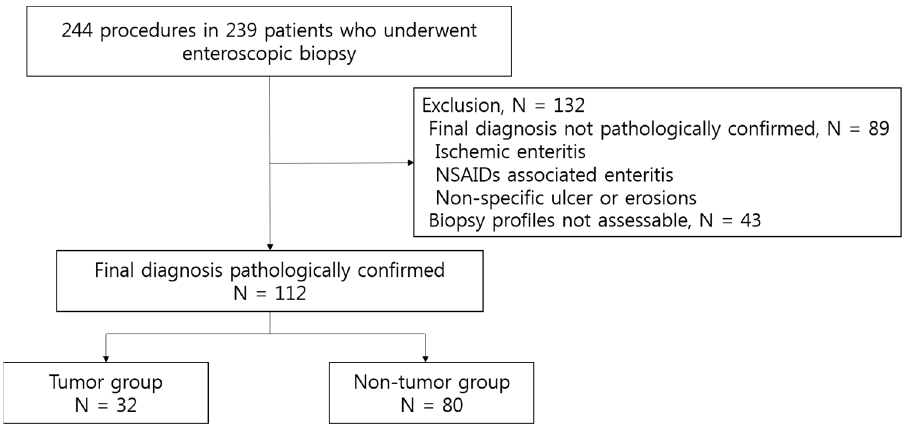
Figure 1. Flow diagram for selection the screening ‐ eligible case.